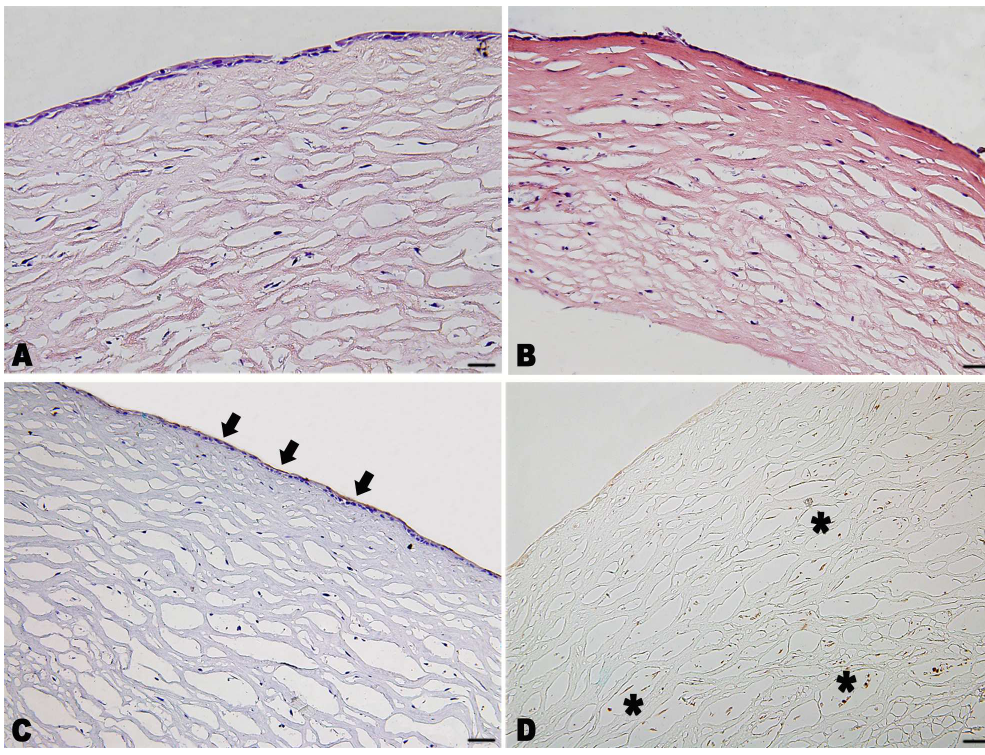
Fig 3. Phenotype and histological sections of the constructedrabbit anterior cornea replacement. (A) H&E stainingshowedtwo or three layersof epithelialcellsformed on the scaffold with a relatively uniform cell distribution in the matrix. (B) H&E stainingof the construct soakedin 100%sterile glycerolfor 5 minutes. (C) Immunohistochemistry stainingfor cytokeratin 3 (brown, black arrow)counterstainedwith hematoxylin (blue),and for vimentin(brown, asterisk) withouthematoxylin staining.Scalebar: 50 μ